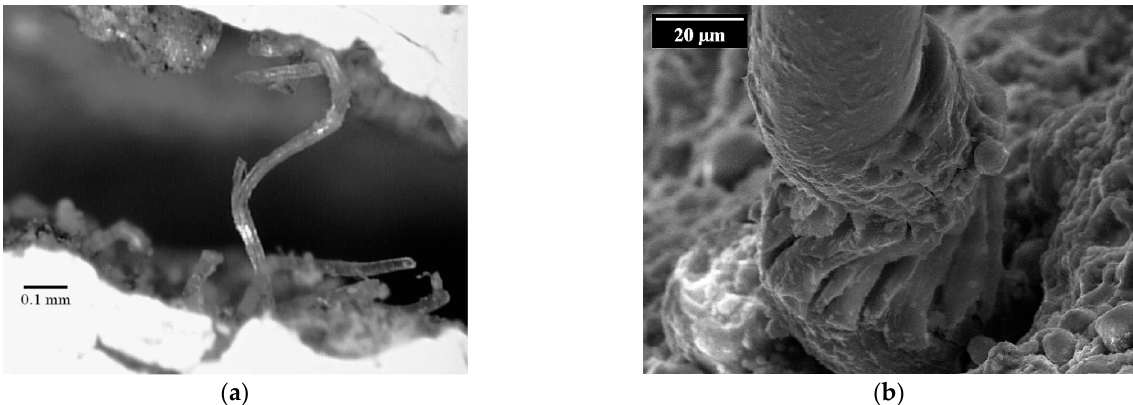
Figure 10. Buckling of crack-bridging fibre in an alternating tension-compression regime: ( a ) microscopic image of a crack [37]; ( b ) a damaged PVA fibre as imaged using electron microscopy [9].